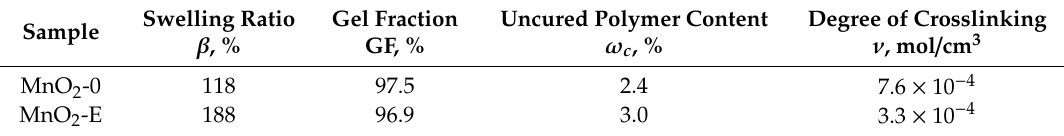
Table 1. Results of the analysis of the degree of crosslinking for MnO 2 -0 and MnO 2 -E samples.